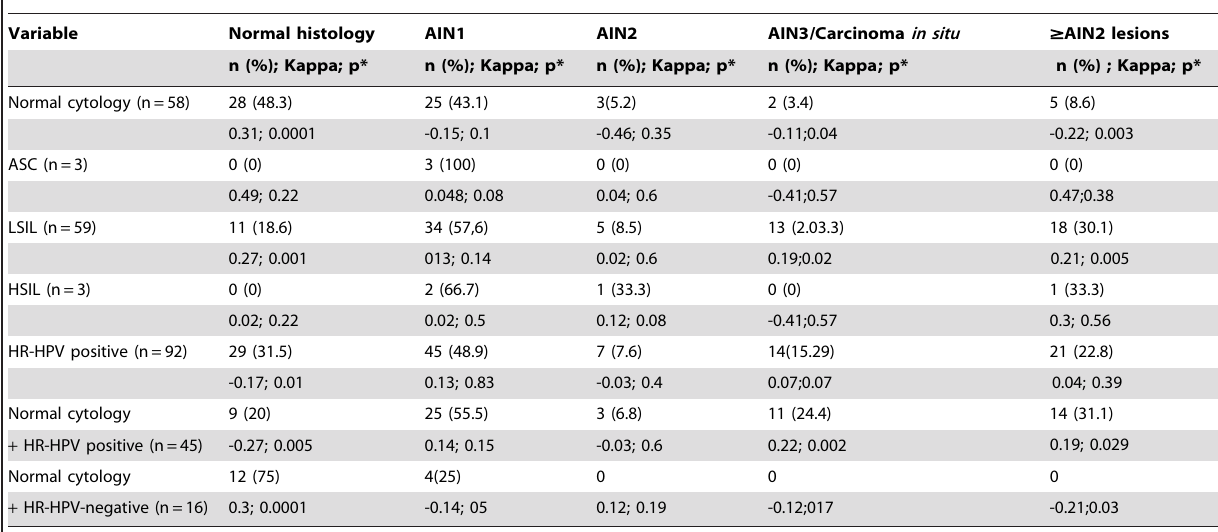
Table 3. Degree of correlation between anal cytology and HR-HPV PCR, with histology